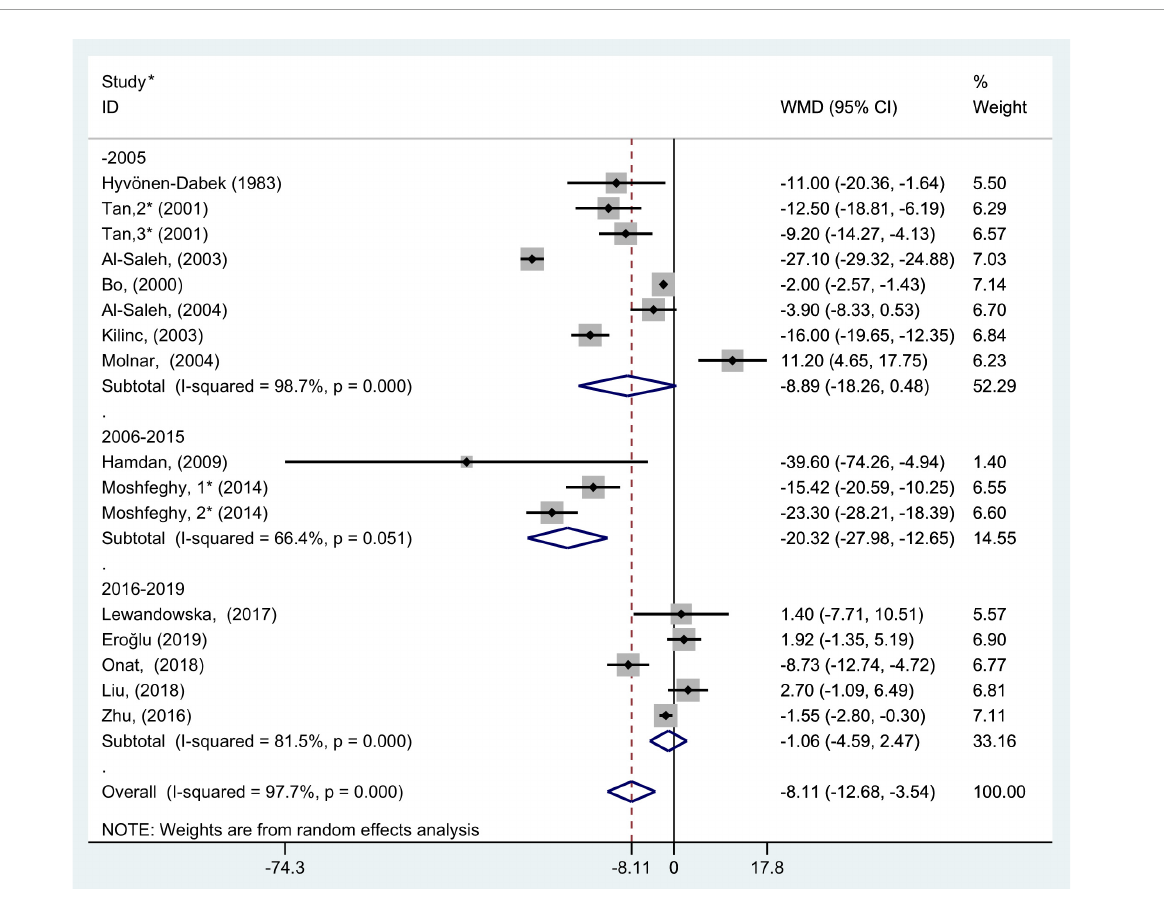
P < 0.001; WMD = − 11.00, 95% CI: − 20.36 to − 1.64, P =